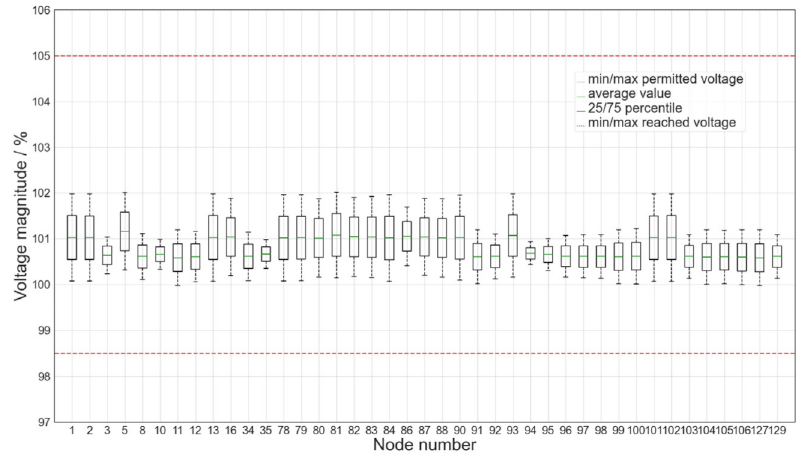
Figure 9. Voltage magnitude on some nodes of the MV grid after optimizing the voltage setpoint of the HV/MV transformer and after grid expansion.